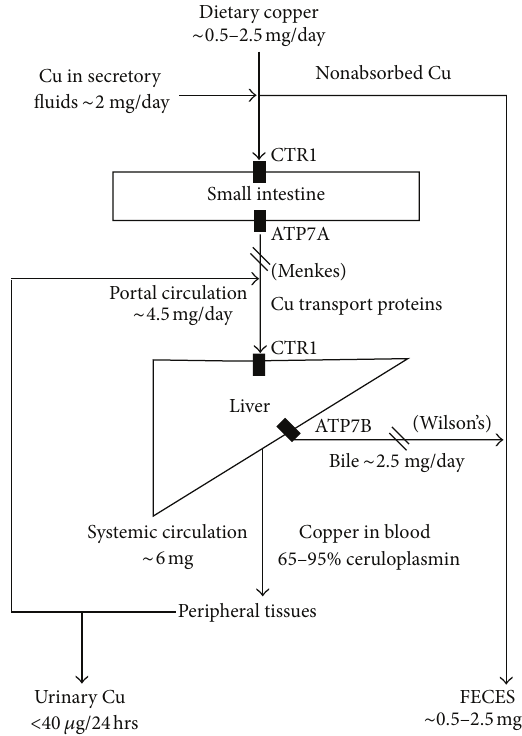
Figure 1: Schematic overview of the major pathways of copper homeostasis. Cu = Copper; CTR1 = Copper Transport Protein 1; ATP7A = Copper transporting ATPase. Mutation is associated with Menkes disease. Encoded by the gene ATP7A; ATP7B = Copper transporting ATPase. Mutation is associated with Wilson’s disease. Encoded by the gene ATP7B; Copper transport proteins include fatty acids, albumin, macroglobulin, histidine, and ceruloplasmin. Disruption to copper uptake (Menkes) and excretion (Wilson’s) pathways represented by \\